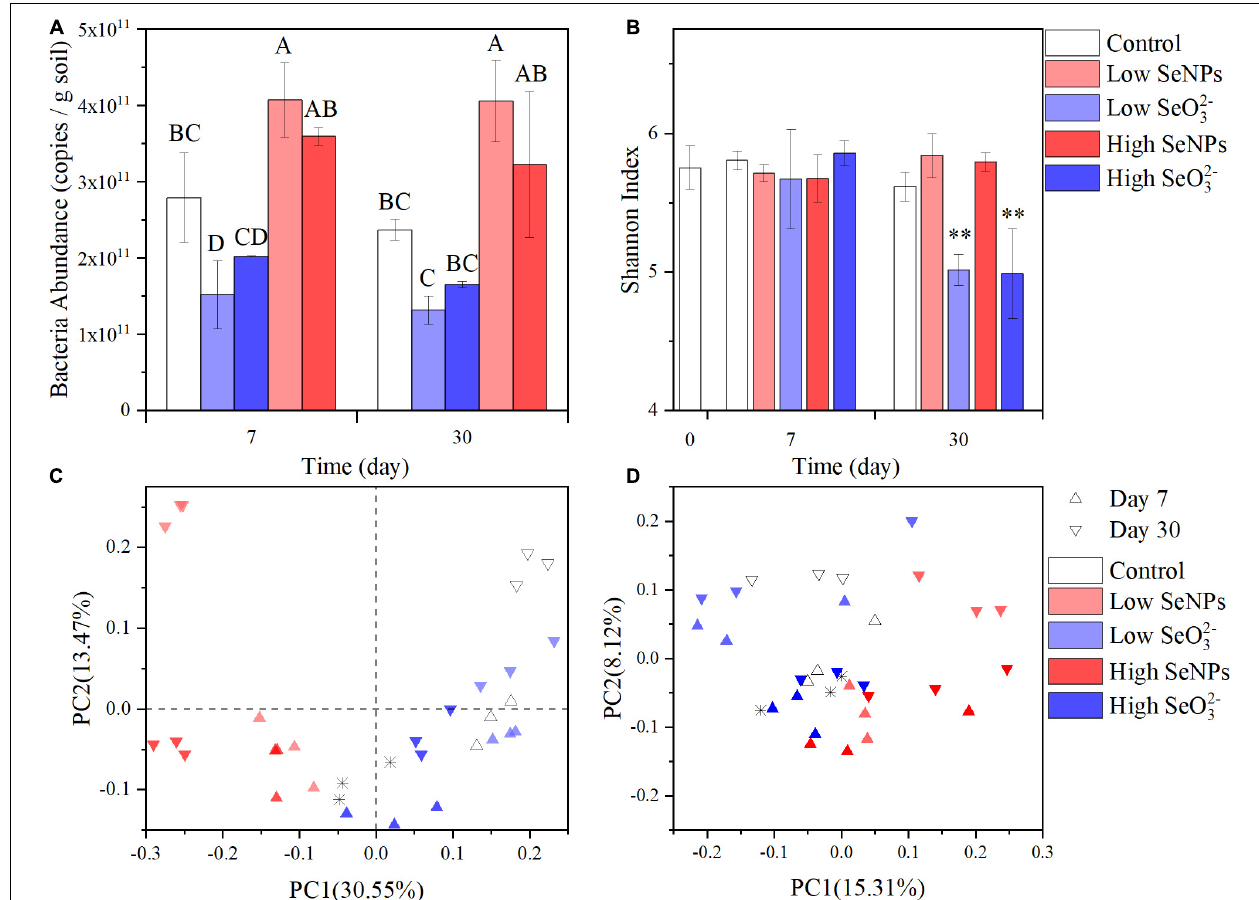
FIGURE 2 | Abundance and diversity of the microbiota in each experimental group. (A) Total soil bacteria abundance. (B) Shannon Index. (C) Principal coordinates analysis (PCoA) plots of Bray–Curtis distances at the genus level. (D) PCoA plots of weighted UniFrac distances at the genus level. Control: the samples collected from the control group without selenium (Se) treatment. High selenite (SeO 32 − ): the samples collected from the group treated with 10 mmol/kg soil SeO 32 − . Low SeO 32 − : the samples collected from the group treated with 1 mmol/kg soil SeO 32 − . High selenium nanoparticles (SeNPs): the samples collected from the group treated with 10 mmol/kg soil SeNPs. Low SeNPs: the samples collected from the group treated with 1 mmol/kg soil SeNPs. ∗ in (C,D) shows the data point of untreated soil. Significant differences were analyzed by ANOVA; ∗∗ p < 0.01. Different letters indicate a significant difference ( p < 0.05).